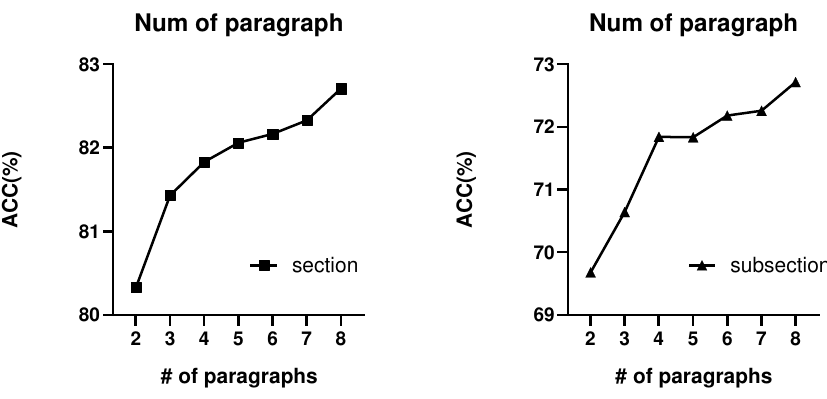
Figure 3. Average Jacc according to the number of paragraphs.